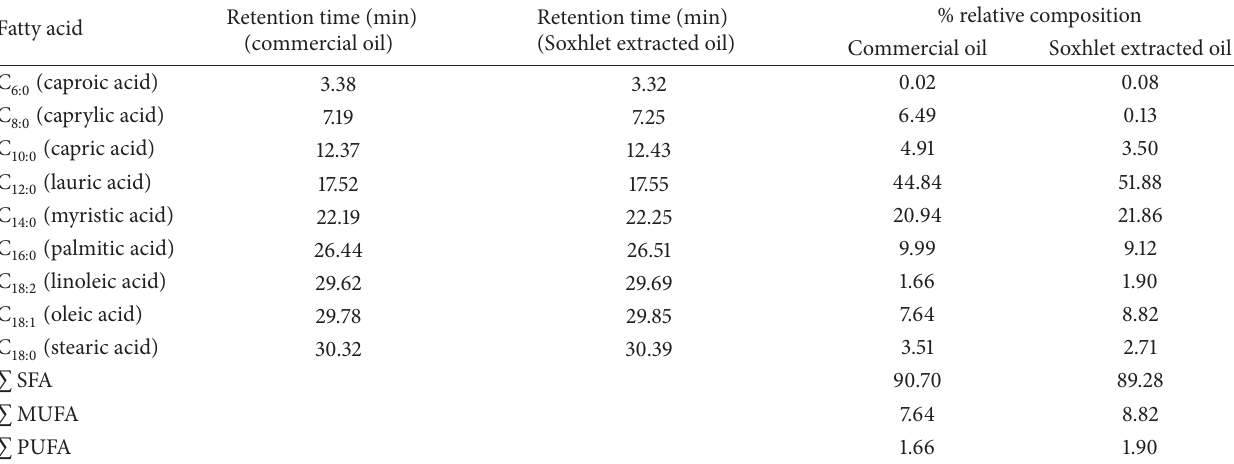
Table 7: Fatty acid composition of coconut copra oils using gas chromatography.